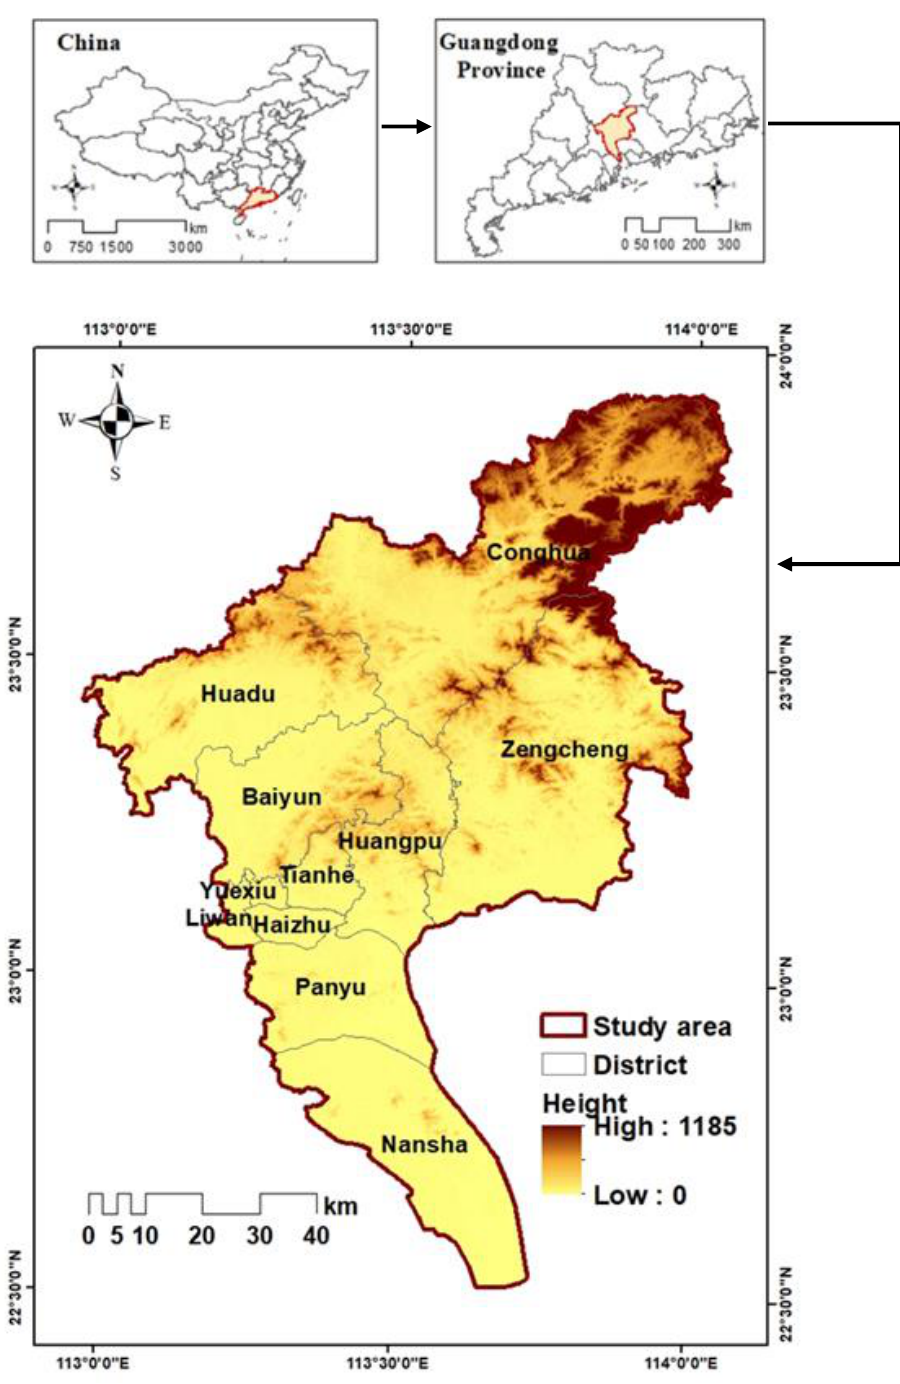
Figure 1. The study